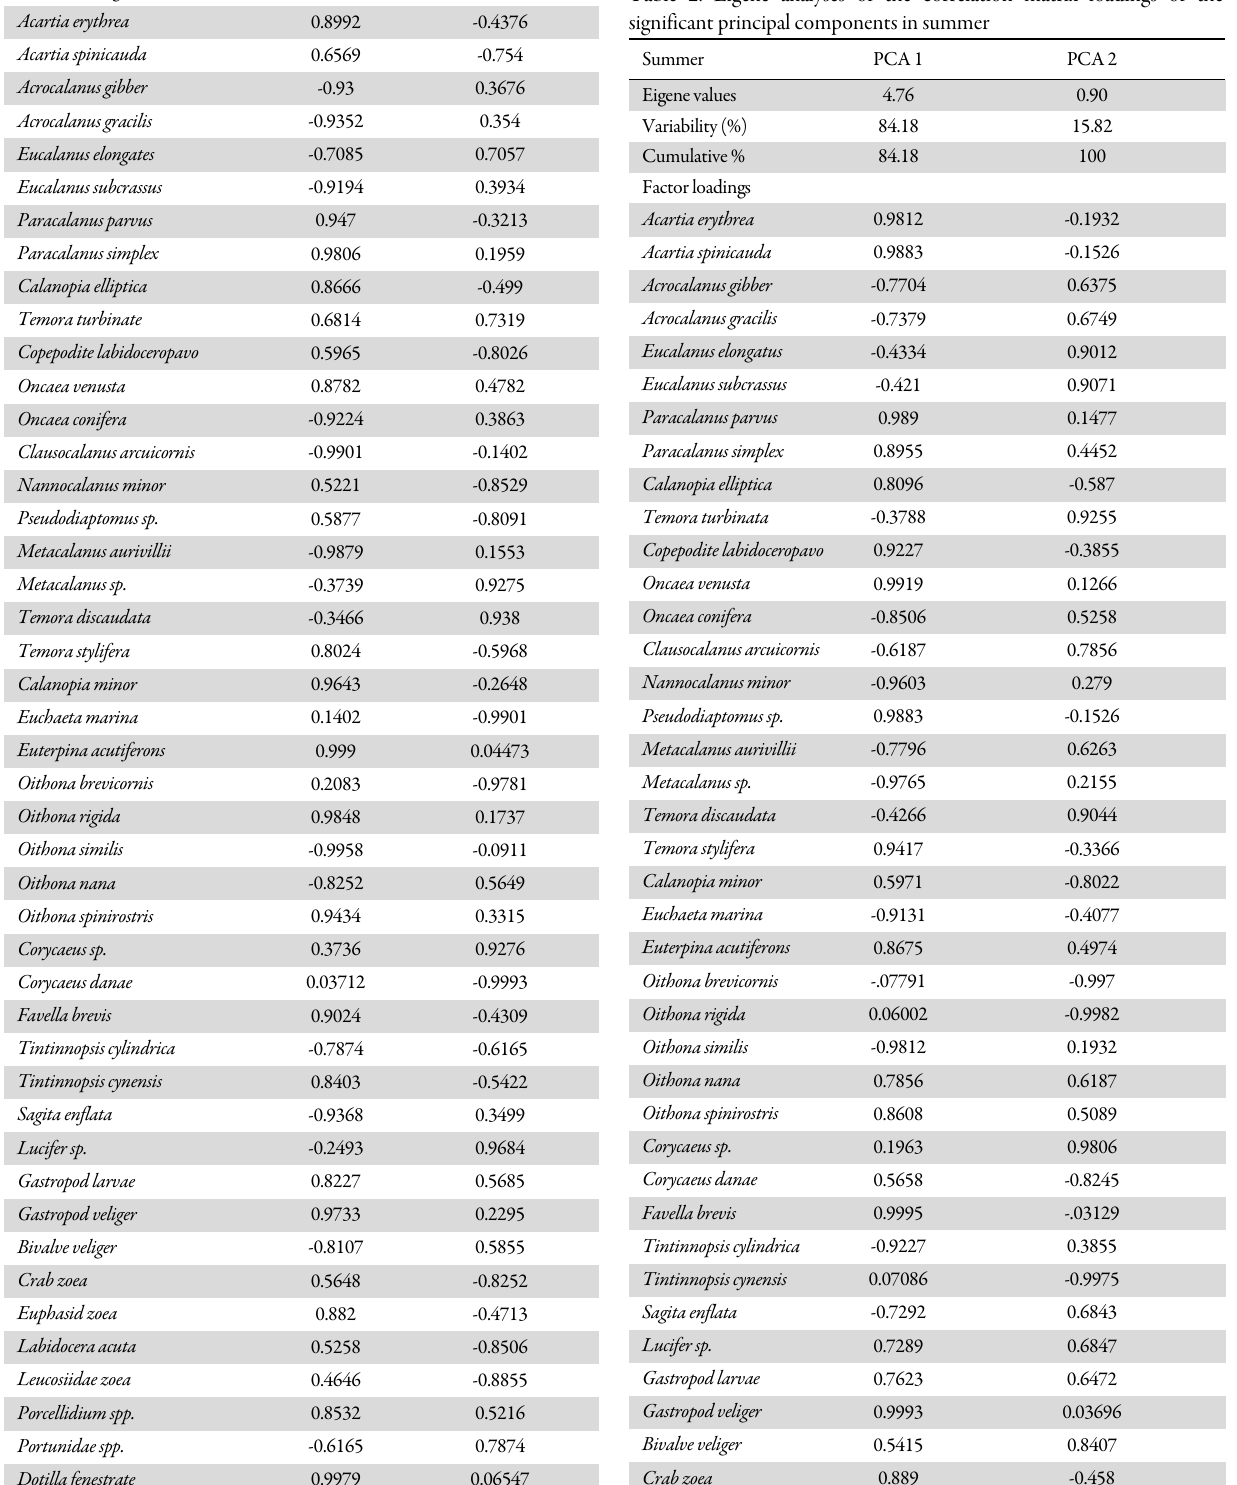
Table 2. Eigene analyses of the correlation matrix loadings of